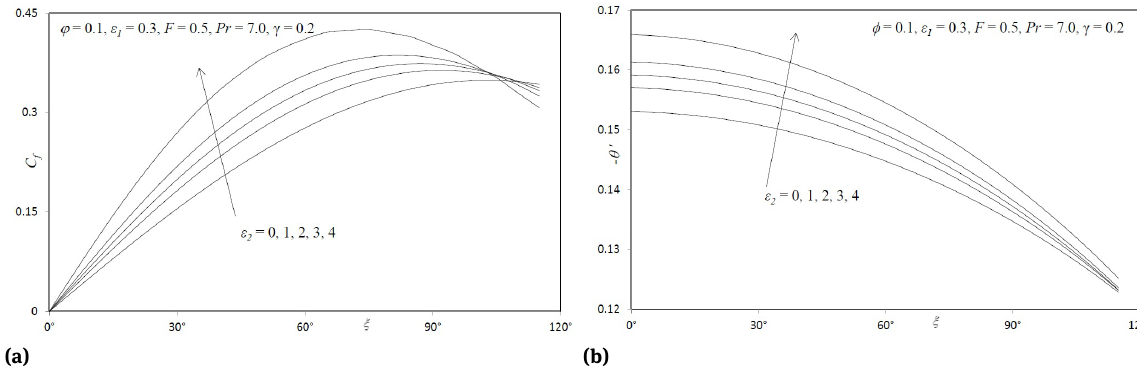
Fig. 11: (a) Effect of ϵ 2 on Skin Friction; (b) Effect of ϵ 2 on Nusselt number